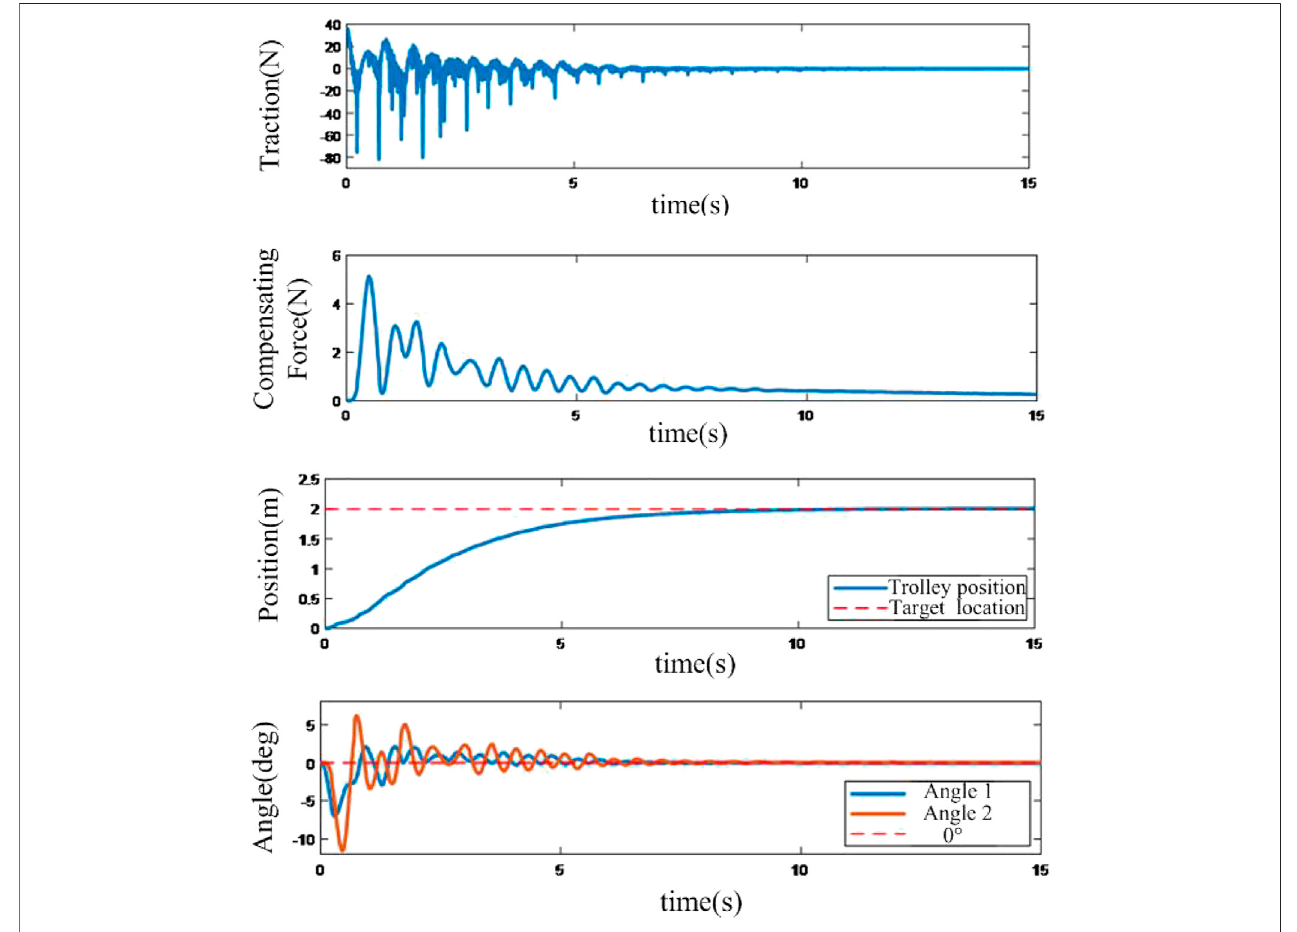
FIGURE 8 | System Response by using neural network compensation adaptive